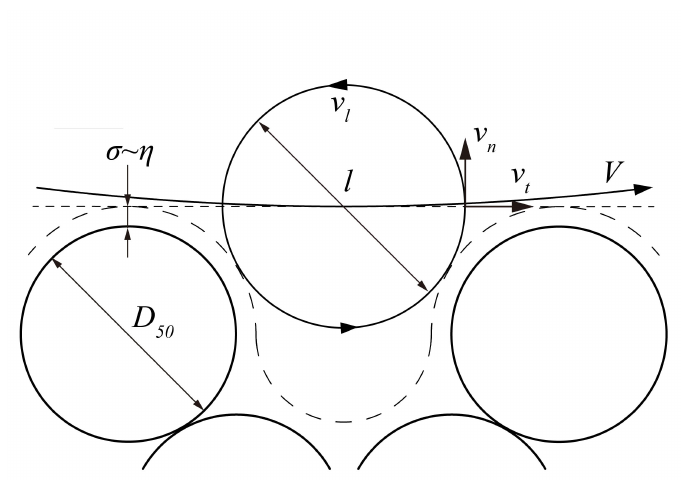
Figure 2. Schematic of eddies triggered by turbulent cauldron on the